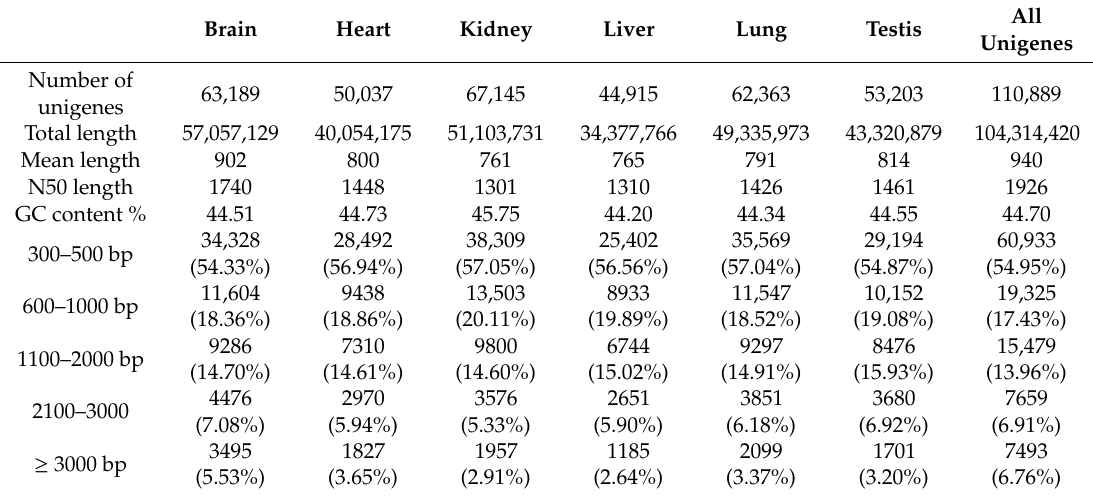
Table 2. Summary of assembled unigenes per tissue.